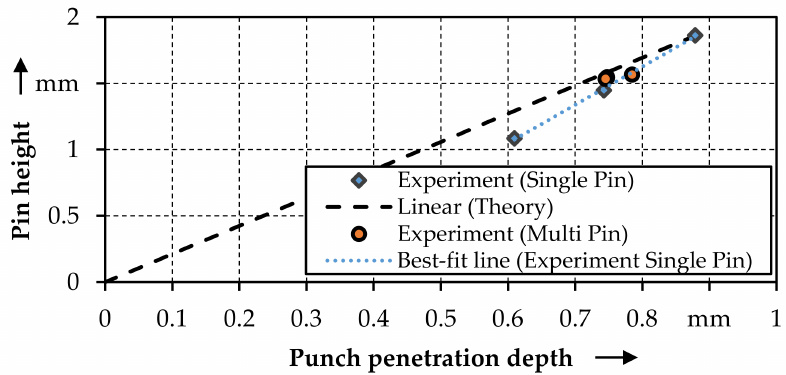
Figure 5. Nonlinear correlation of the measured pin height to the punch penetration depth.